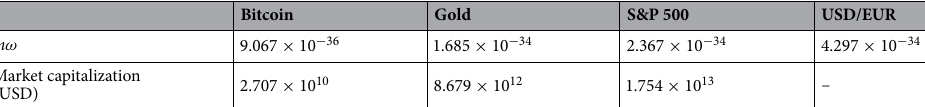
Table 8. Market capitalization and the speed of information discovery. The m ω values are estimated through the QHO model. Market capitalization represents the average daily market capitalization during the sample period. The daily market capitalization of Bitcoin and S&P 500 is retrieved from Quandl.com and the Center for Research in Security Prices, respectively. The daily market capitalization of gold is estimated by multiplying daily gold prices with the yearly above-ground gold reserves provided by World Gold Council. As the definition of market capitalization of USD/EUR is ambiguous, we have not directly made a comparison with the ω of USD/EUR. The period of data collection was from September 10, 2010, to March 31, 2019. To match the sample period of Bitcoin and that of the other assets, we extract daily data excluding the holidays for